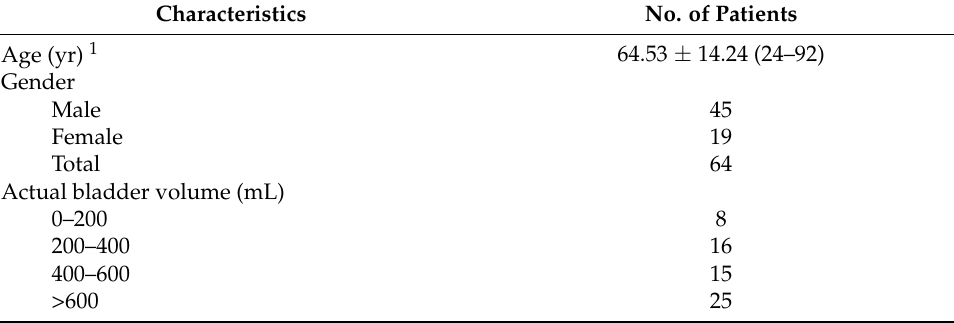
Table 1. Patient